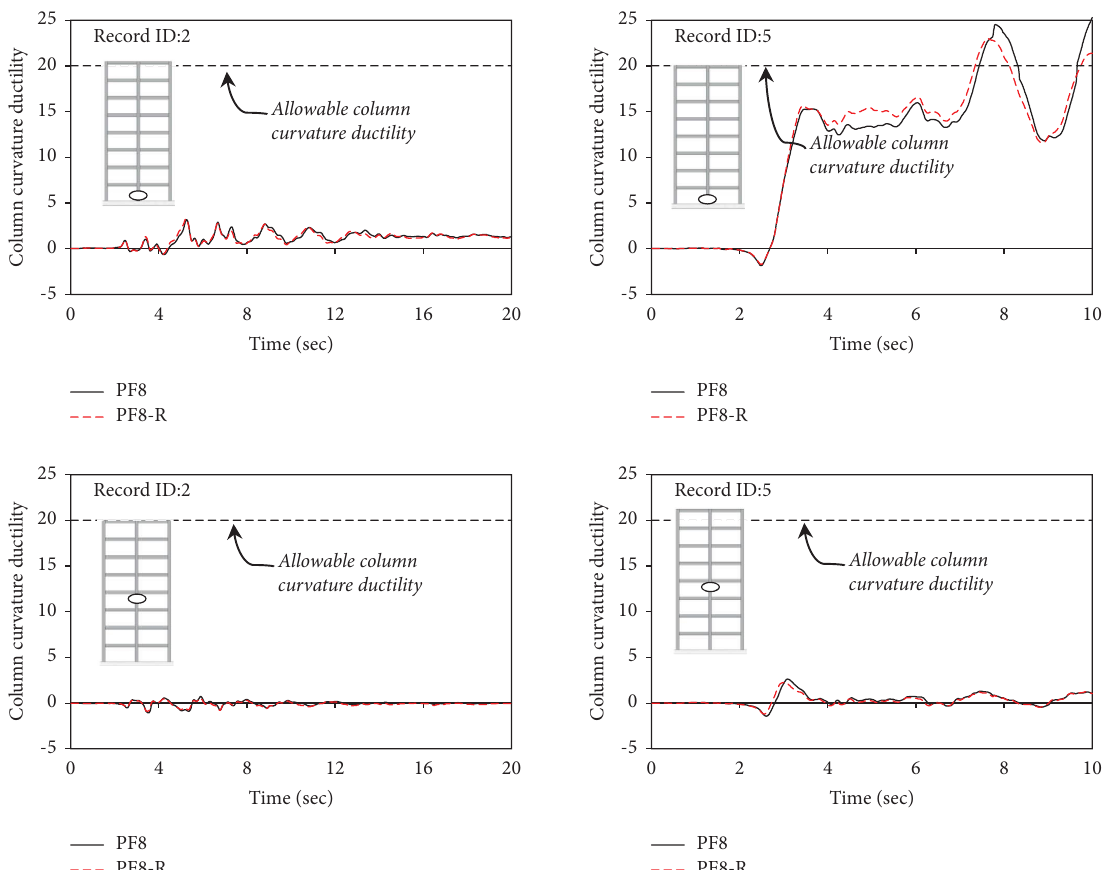
Figure 19: Time histories of curvature ductility demand placed upon the columns of the eight-story frames subjected to Kobe and Northridge earthquake ground